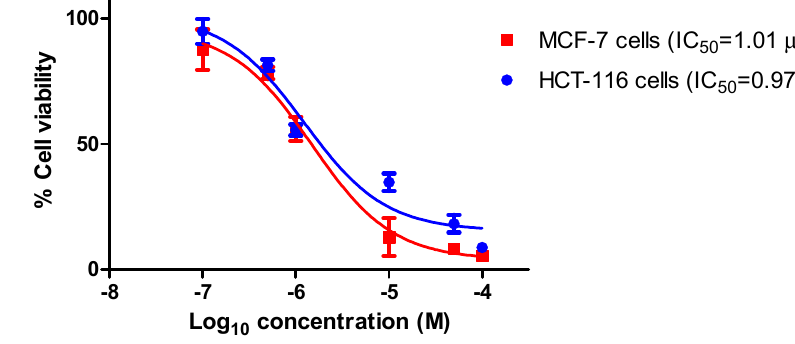
On the other hand, the substituent on the benzylidene moiety has also a great impact on the antiproliferative activity. As shown in Table 2, p -fluoro benzylidene derivatives 7e , 8e , and 9e derivatives affected the cell viability of both cell lines in lower micromolar range compared to their analogs containing p -chloro ( 7b , 8b , and 9b ) or p -bromo ( 7c , 8c , and 9c ) benzylidene derivatives (Table 2). Thus, the presence of fluorine atoms significantly improves the pharmacological and physicochemical properties as the metabolic stability, lipophilicity as well as ligand binding [28,29], these results also agreed with the reported results by Bai et al. [22]. The replacement of fluorine atoms in compounds 7e , 8e , and 9e with by hydroxy group as in compounds 7d , 8d , and 9d showed also good antiproliferative activities against MCF-7 cell line with IC 50 = 18.2, 14, and 10.4 µM, respectively (Table 2). These results agreed with the reported results which indicated that the phenolic hydroxyl group acts as a hydrogen donor which improves the anticancer activity [21,24].